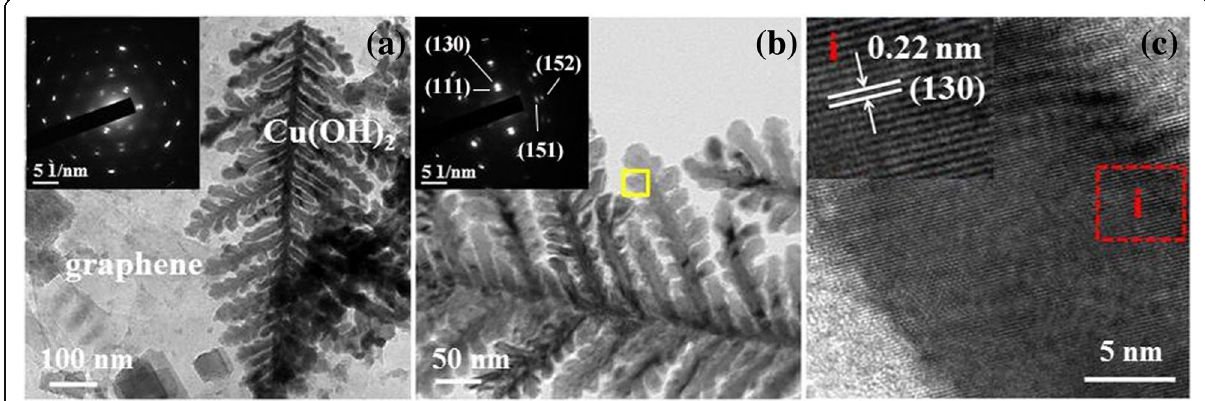
Fig. 4 a TEM image of the Cu(OH) 2 /graphene composite. The inset SAED pattern originates from graphene nanosheets. b High-magnification TEM image with the SAED of one branch of cypress leaf-like Cu(OH) 2 in the inset. c High-resolution TEM image of the marked area in Fig.